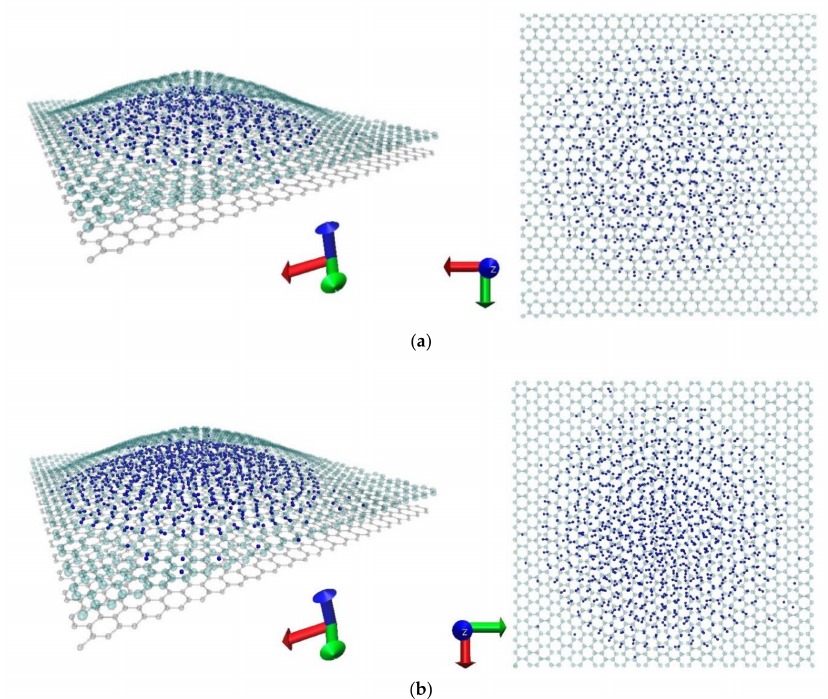
Figure 3. Hydrogen storage by graphene nanoblister: ( a ) a super-cell with 4.17 wt % of H-atoms; ( b ) a super-cell with 6.86 wt % of H-atoms (hydrogen atoms and molecules are noted by blue beads).